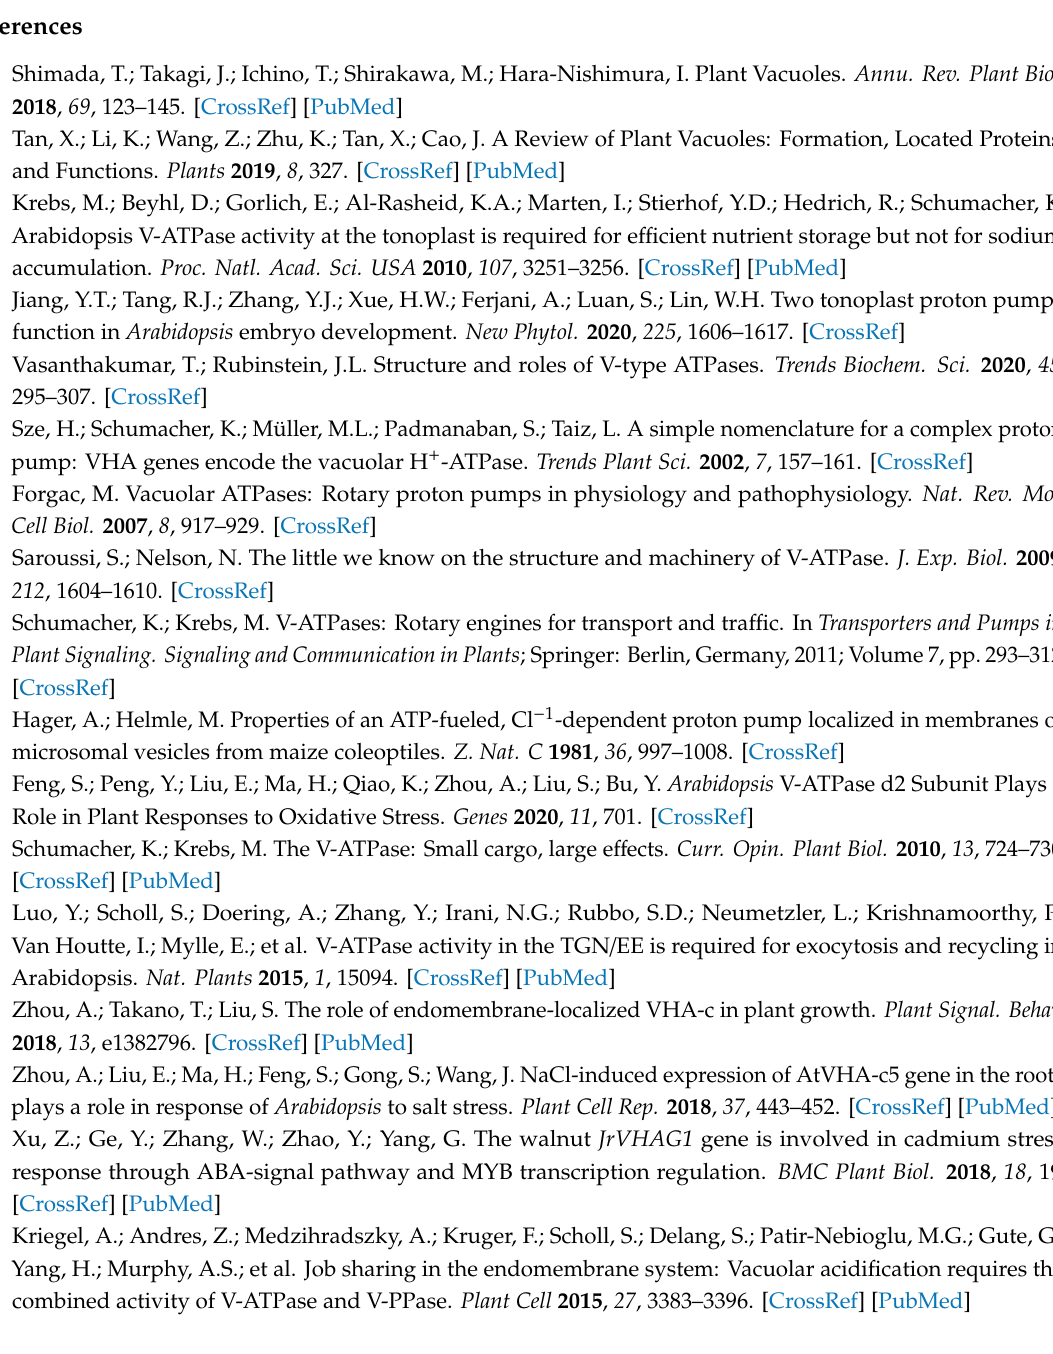
Figure S6. Expression patterns of VHA genes at six key fruit developmental stages of four pear cultivars. Figure S7. Expression profiles of PbrVHA genes of five pear cultivars during fruit senescence after harvesting. Table S1: Detailed information of all VHA gene family genes identified in the five Rosaceae